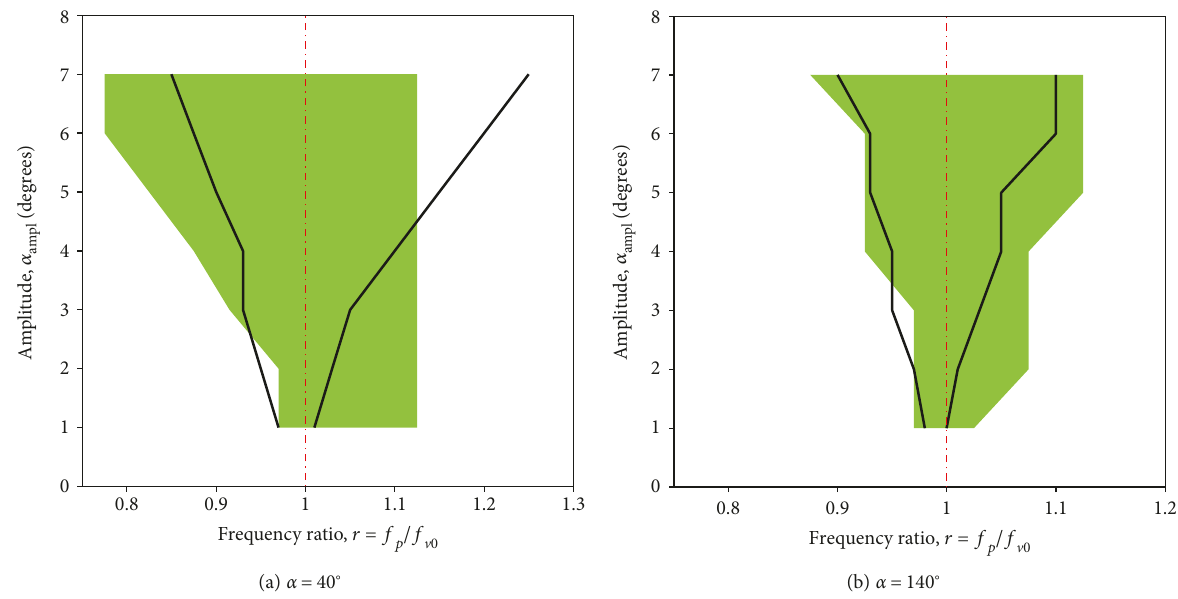
Figure 14: Proposed lock-in boundaries for pitching amplitude analysis at two incidences: VIV model (in black line) and CFD model (in